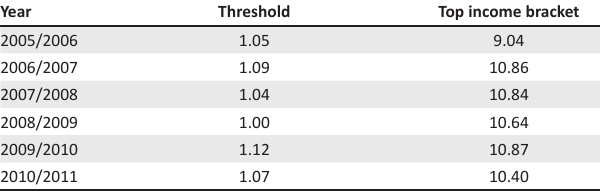
TABLE 2: Tax-free threshold and top income bracket